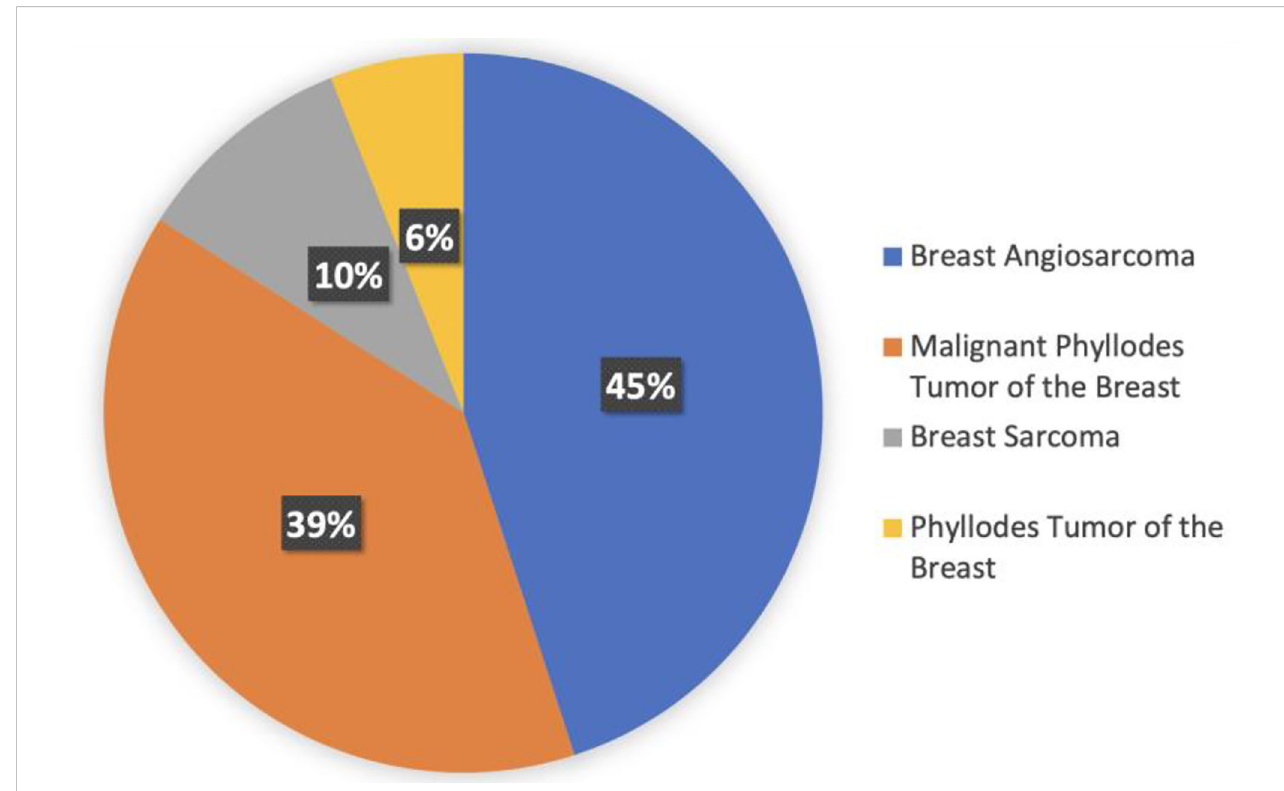
FIGURE 4 Histology distribution within the breast sarcoma